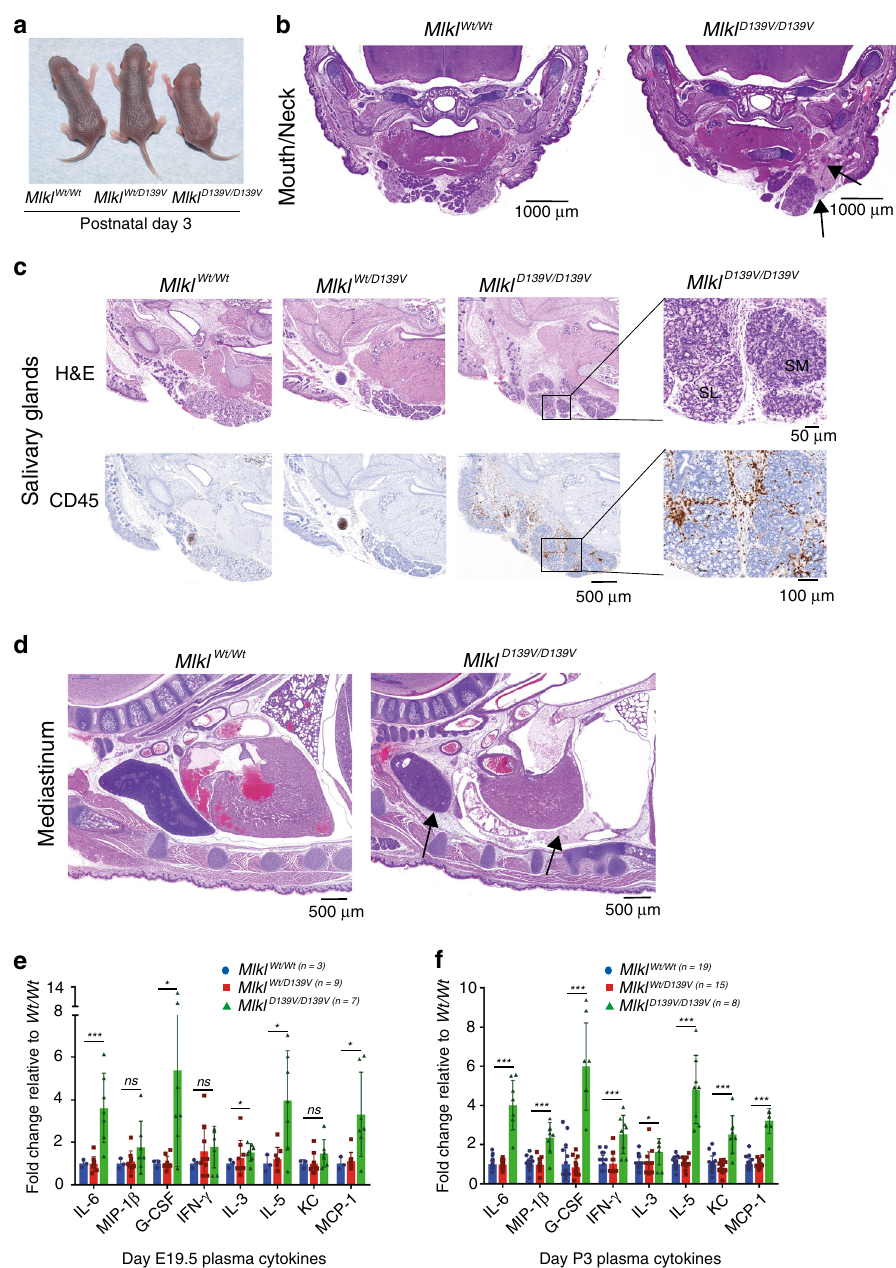
Fig. 2 Homozygous Mlkl D139V neonates exhibit dispersed upper body in fl ammation. a Macroscopic appearance of Mlkl Wt/Wt , Mlkl Wt/D139V and Mlkl D139V/D139V mice at postnatal day 3. b Coronal section of mouth and neck region of postnatal day 2 litter mates stained with hematoxylin and eosin (H&E). Dilated blood vessels and edema are indicated by arrows. c Serial mandible sections from postnatal day 3 litter mates stained with H&E and anti- CD45. Inset black boxes are magni fi ed in right panel. SL, sublingual gland. SM, submandibular gland. Images representative of n = 3 – 4 P3 pups per genotype. d H&E stained sections from mediastinum of postnatal day 2 litter mates. Thymic cortical thinning and pericardial in fi ltration are indicated by arrows. For full anatomical annotations for ( b ) and ( d ) see Supplementary Fig. 2h. ( b ) and ( d ) representative of n = 5 – 6 P2 pups examined with similar characteristics. Scale bars for ( b – d ) range from 50 to 1000 μ m as indicated. Multiplex measurement of plasma cytokine levels at E19.5 ( e ) and postnatal day 3 ( f ). Each symbol represents one independent pup sampled; Mlkl Wt/W t – blue circles, Mlkl Wt/D139V - red squares, Mlkl D139V/D139V - green triangles, with bar height and error bars representing mean ± SD respectively for n = 3 – to 19 pups as indicated. * p ≤ 0.05, ** p ≤ 0.01, *** p ≤ 0.005 calculated using an unpaired, two-tailed t background. Homozygous Mlkl D139V/D139V pups were born at expected Mendelian frequencies (Supplementary Table 1) and were ostensibly normal macroscopically and histologically at E19.5